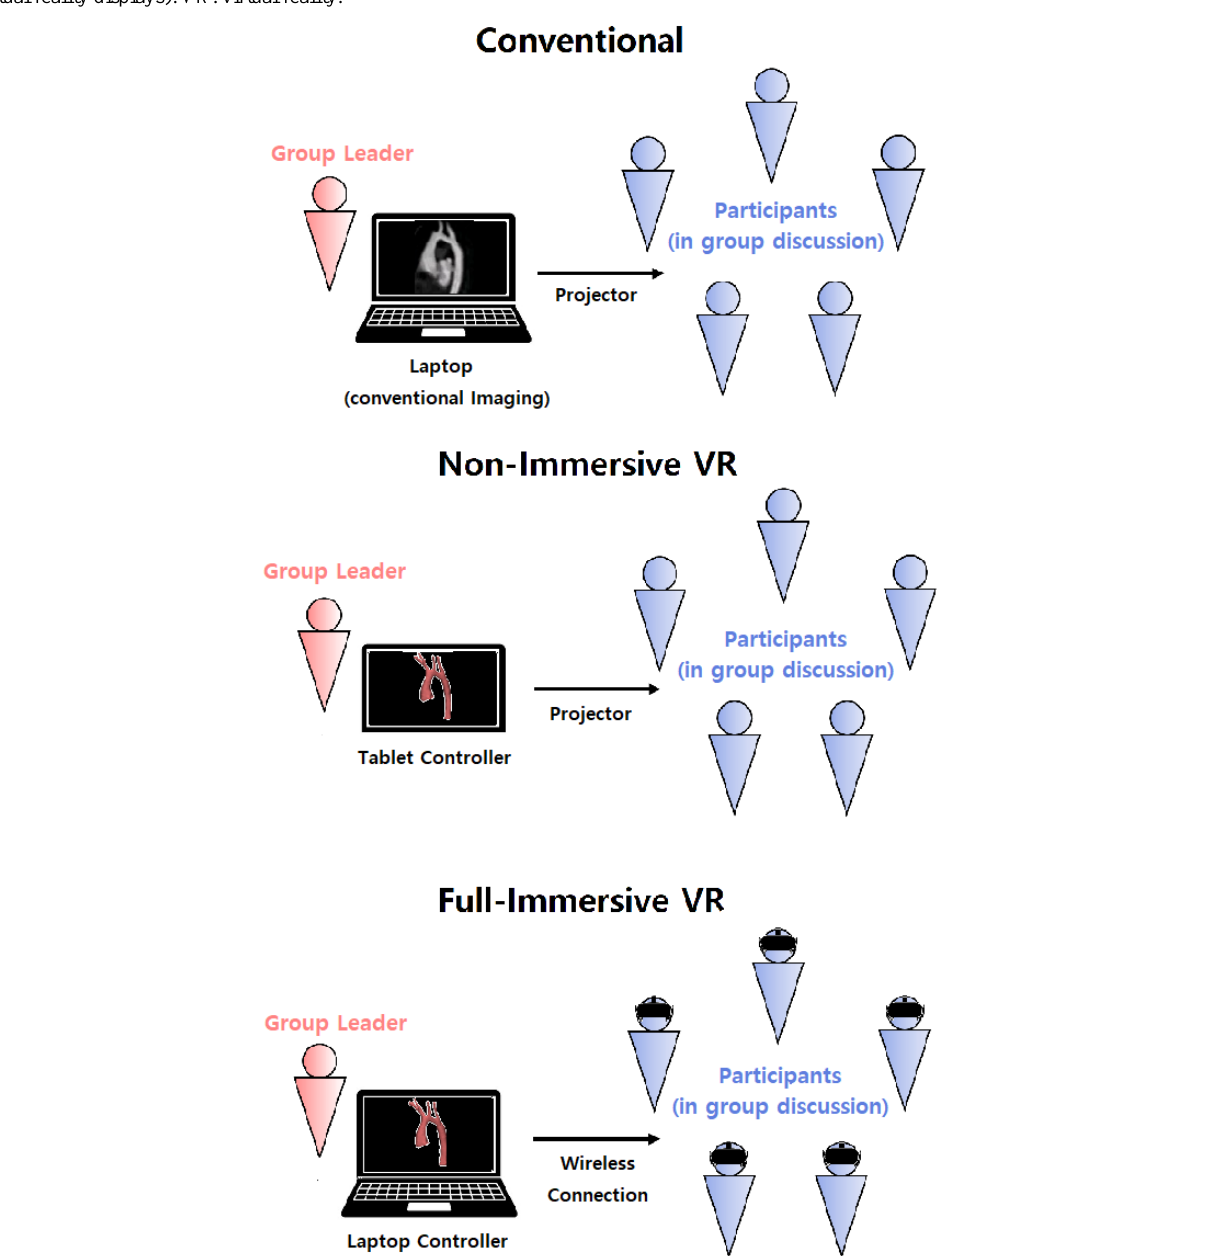
Figure 4. Diagram of group discussion format for each display system (from the top: conventional, nonimmersive virtual reality, and full-immersive virtual reality displays). VR: virtual